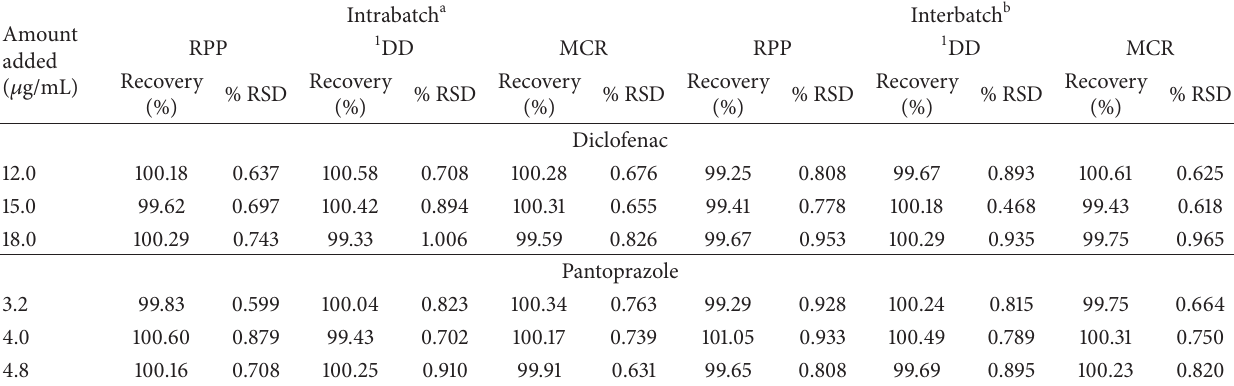
Table 2: Accuracy and precision results of diclofenac and pantoprazole in bulk form using the proposed methods. Amount added ( 𝜇